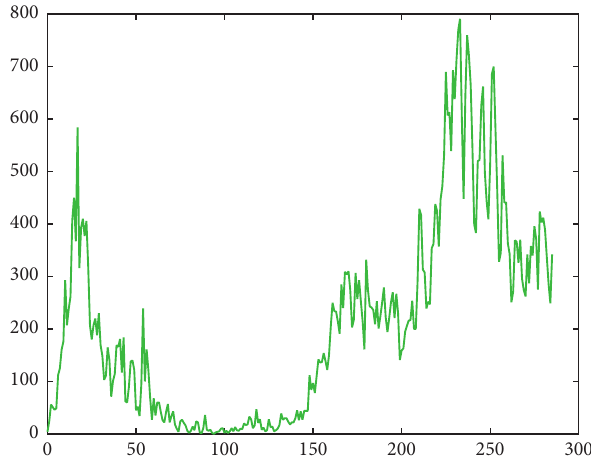
Figure 1: Number of new daily infected individuals in Galicia, starting March 13,